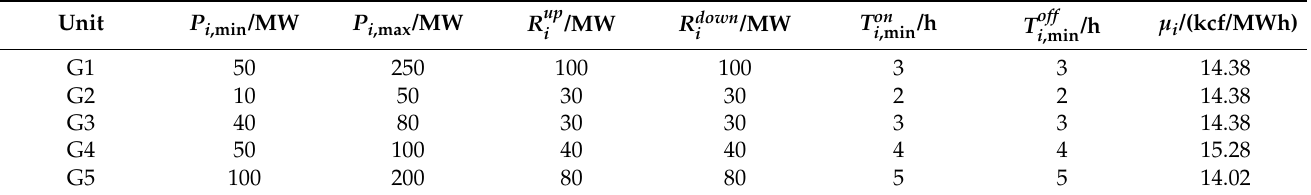
Table A2. Technology parameters of